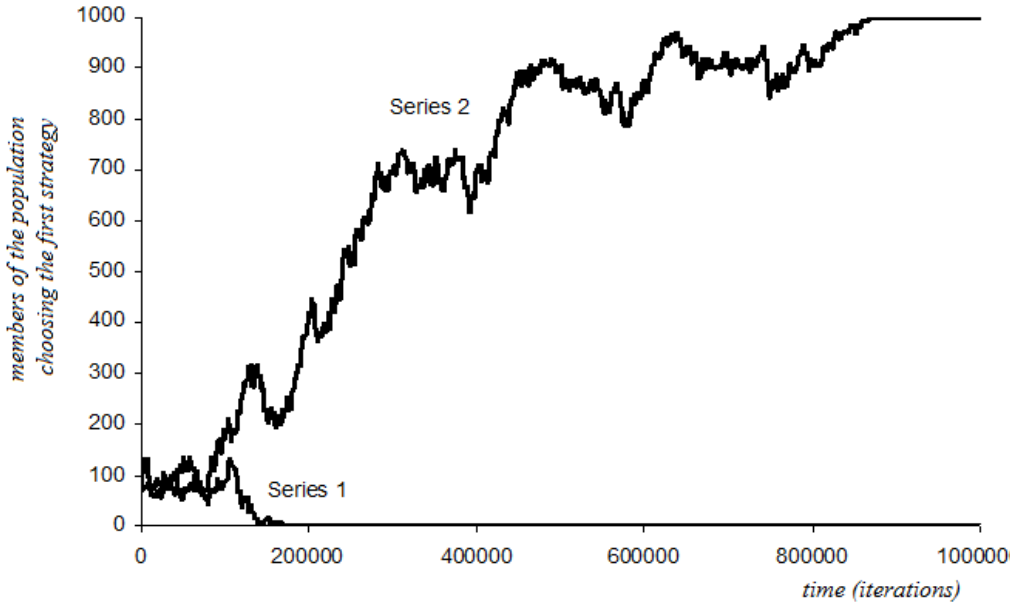
Figure 2. ‘ Stag-Hunt ’ when 90% of players are, initially, drawn to the inefficient outcome (Series 1). The introduction of few intruders sets them on a course to the efficient outcome (Series